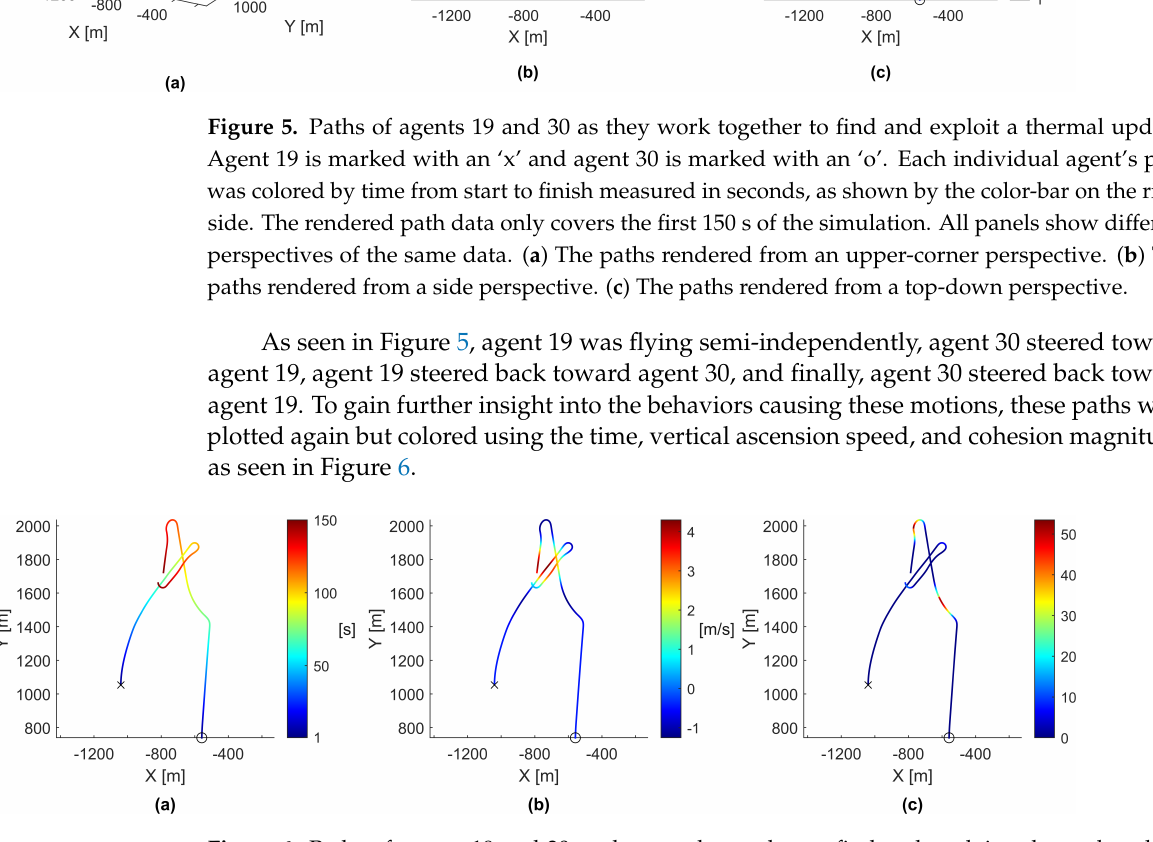
Figure 6. Paths of agents 19 and 30 as they work together to find and exploit a thermal updraft, viewed from a top-down perspective. Agent 19 is marked with an ‘x’, while agent 30 is marked with an ‘o’. The rendered path data only covers the first 150 s of the simulation. ( a ) The paths colored by time in seconds, provided for comparison purposes. ( b ) The paths colored by vertical velocity in meters per second. ( c ) The paths colored by cohesion magnitude to surrounding